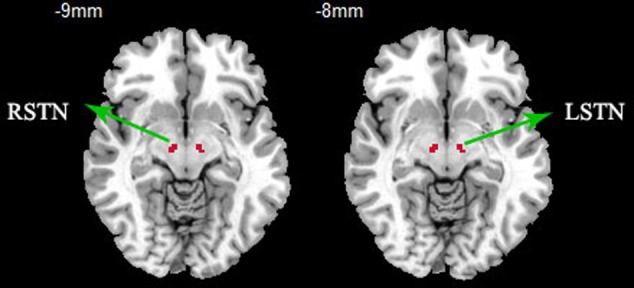
ROI presentation of subthalamic nucleus (STN). ROI definition of the STN, bilateral STNs were defined as regions of interest from the WFU_pickatla, the centers of the left and right STN were [-9, -12, -8] and [9, -14, -8].